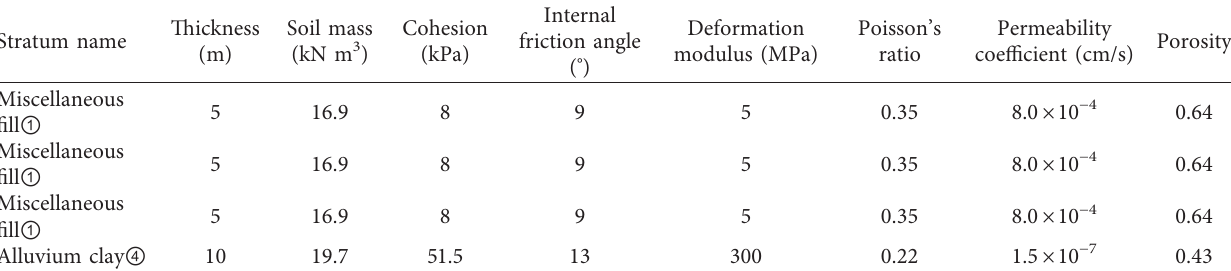
Figure 9: Simulation results of lining stress of line 1 (unit: Pa). (a) Line 5 tunnel not constructed. (b) After the construction of right-line tunnel of line 5. (c) After the construction of double-line tunnel of line 5. Table 4: Strength-weakening scheme of soil